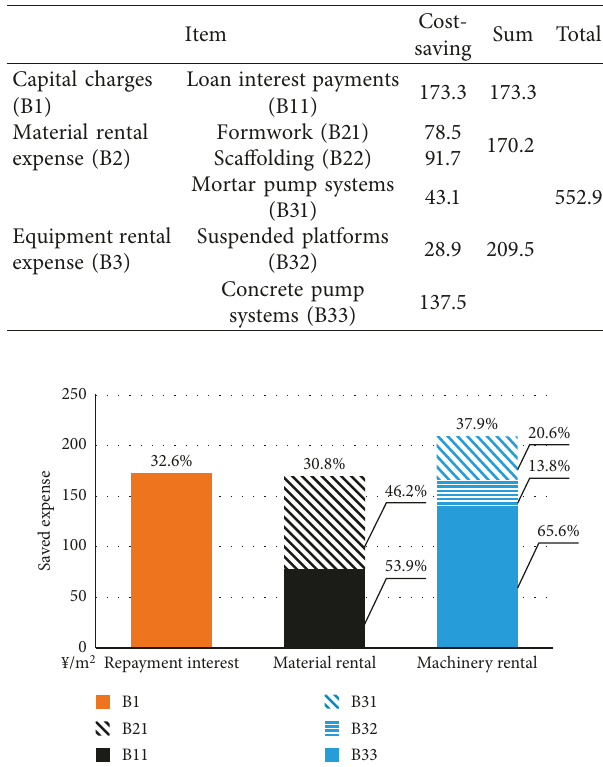
Table 2: Project financing and investment plans.